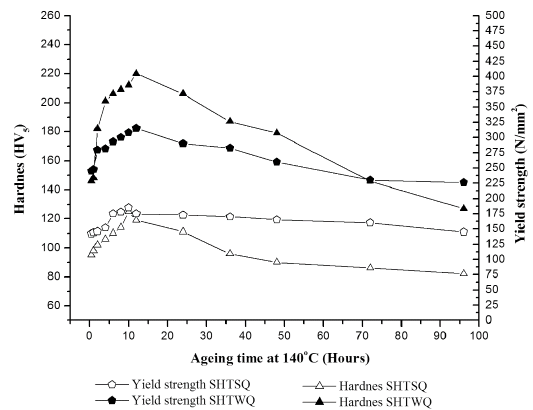
Figure 4. The relationship between ageing time and UTS and hardness for SHTWQ and SHTSQ & 8% pre-strained test samples aged at 140 °C.